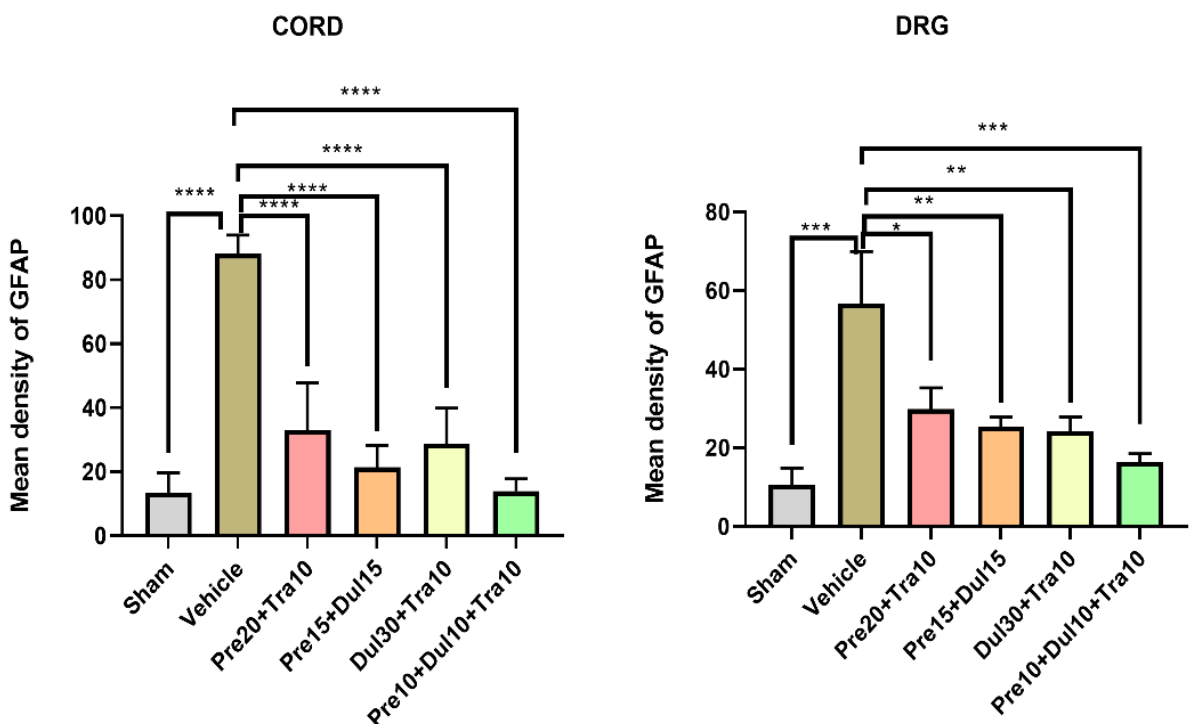
Figure 4. Histogram representing the optical density of GFAP in spinal cord, DRG from sham (n = 4), and normal saline-treated ( n = 4) CPIP mice. Pre20 mg/kg + Tra10 mg/kg-treated ( n = 6) CPIP mice, Pre15 mg/kg + Dul15 mg/kg-treated ( n = 6) CPIP mice, Dul30 mg/kg + Tra10 mg/kg-treated ( n = 6) CPIP mice, Pre10 mg/kg + Dul10 mg/kg + Tra10 mg/kg-treated ( n = 6) CPIP mice. The expression of GFAP in the four treated group was significantly decreased compared to the normal saline treated group. GFAP, glial fibrillary acidic protein; DRG, dorsal root ganglia; Pre, pregabalin; Dul, duloxetine; Tra, tramadol; CPIP, chronic post-ischemic pain. * p < 0.05, ** p < 0.005, *** p < 0.001, **** p < 0.0001.